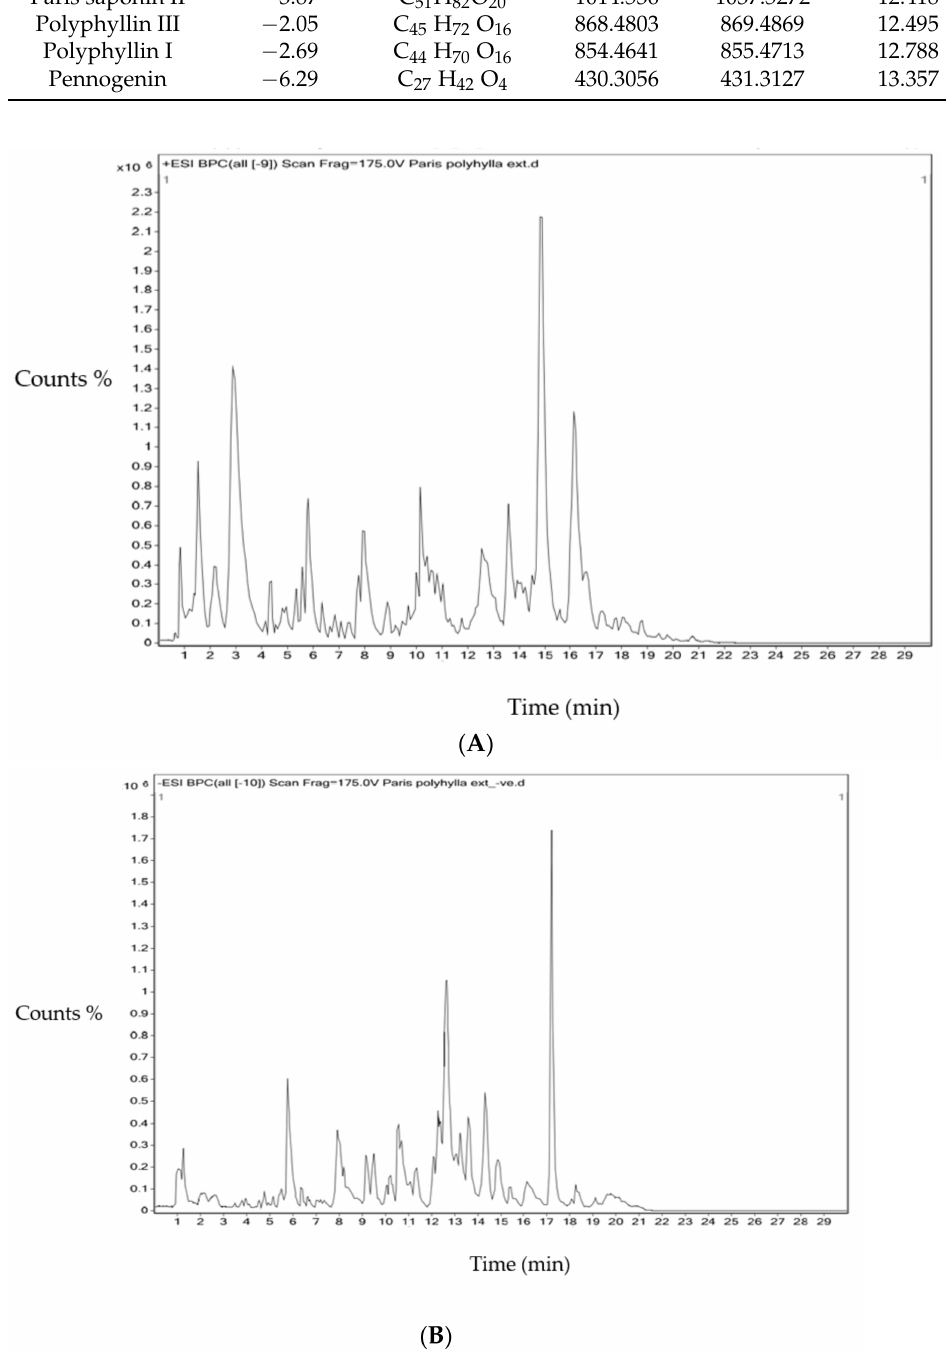
Figure 9. Total ion chromatogram of PPE: ( A ) Positive mode and ( B ) Negative mode of